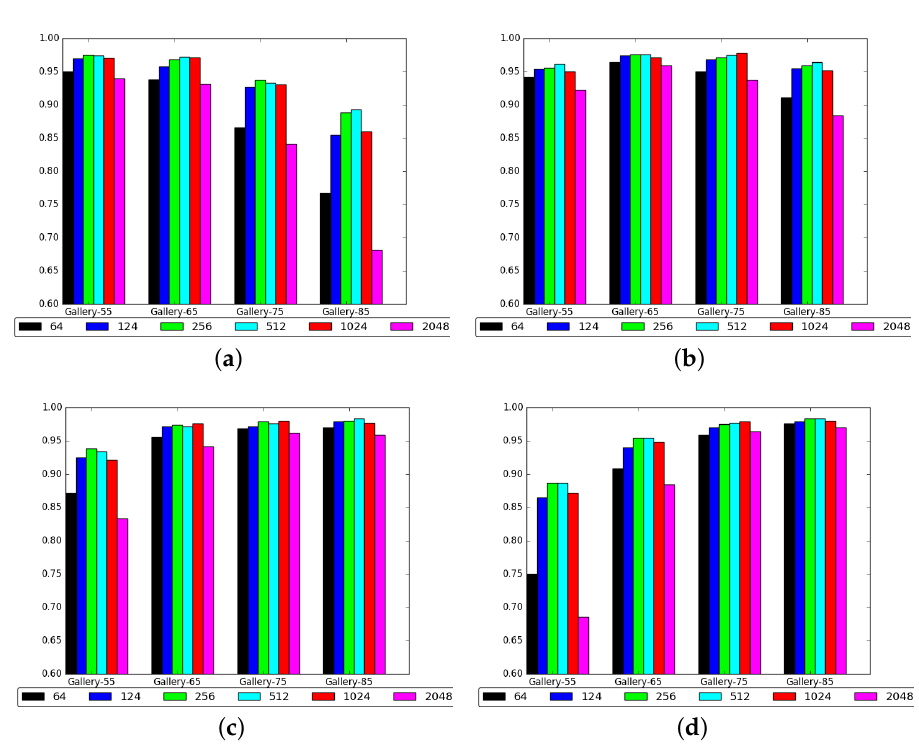
Figure 3. Rank-1 identification rates of different number of components after PCA under different Gallery-view and Probe-view combinations. (JB). ( a ) Probe-55; ( b ) Probe-65; ( c ) Probe-75; ( d )